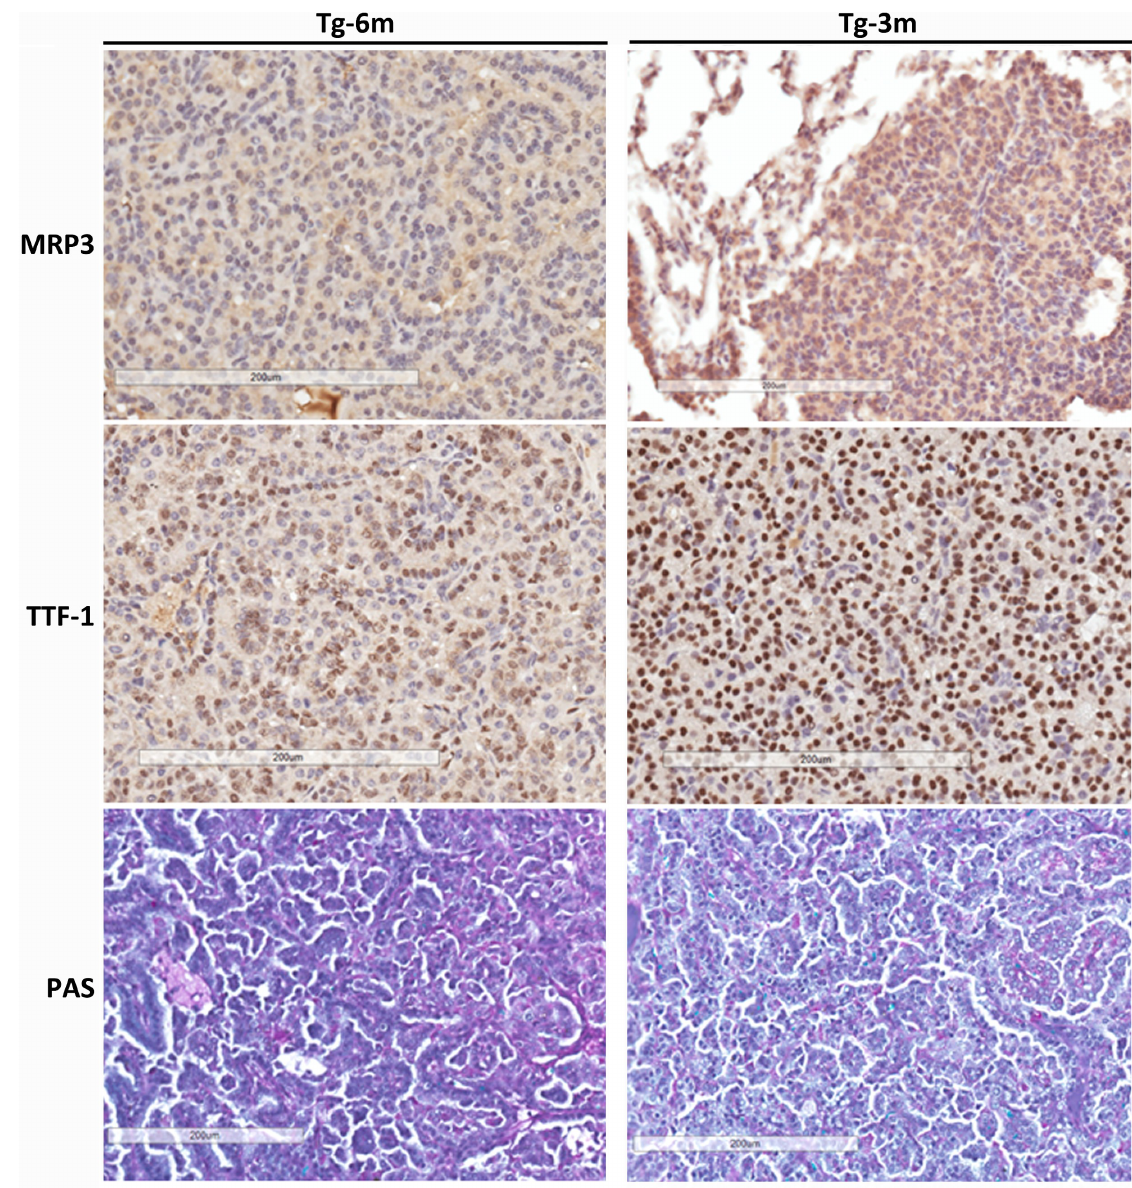
Fig 2. IHC analysis revealslung tumors are displaying markersrelated to adenocarcinoma. IHC evaluation of multidrug resistant protein 3 (MRP3), thyroid transcriptionfactor (TTF)-1, and periodicacid-Schiff (PAS) stain in tumors obtainedat 6 (Tg-6m) and 3 months (Tg-3m). MRP3 expressionwas only diffused in Tg-3m lung tumors. Nuclei from tumor cells of both Tg-6m and Tg- 3m were stainedwith TTF-1; it was more intense in Tg-3m than Tg-6m tumor cells. Both Tg-6m and Tg-3m tumor samples were PAS-positive. Panels are at 200x magnification. The scale bar showed200 μ m in distance.